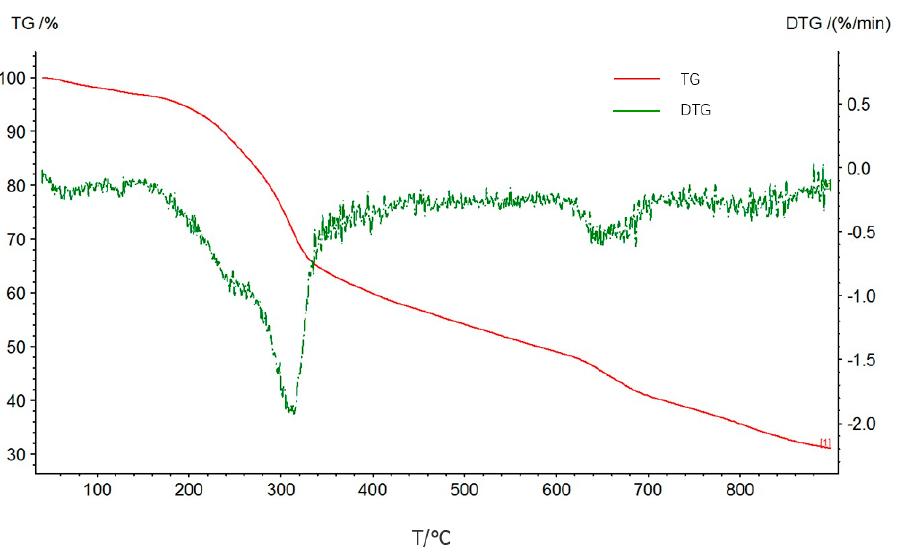
Figure 1. The TG and DTG curves of the chicken manure at a heating rate of 5 °C/min in the presence of nitrogen atmosphere.